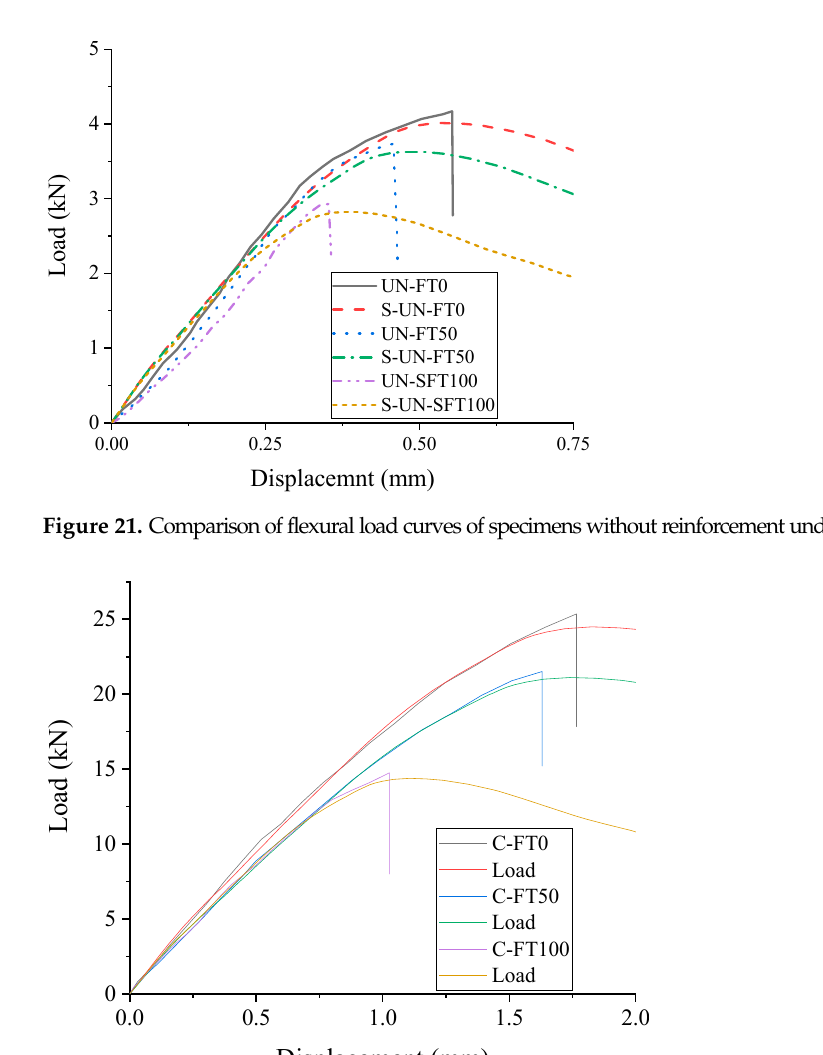
Figure 22. Comparison of flexural load curves of CFRP-reinforced specimens under freeze–thaw action.